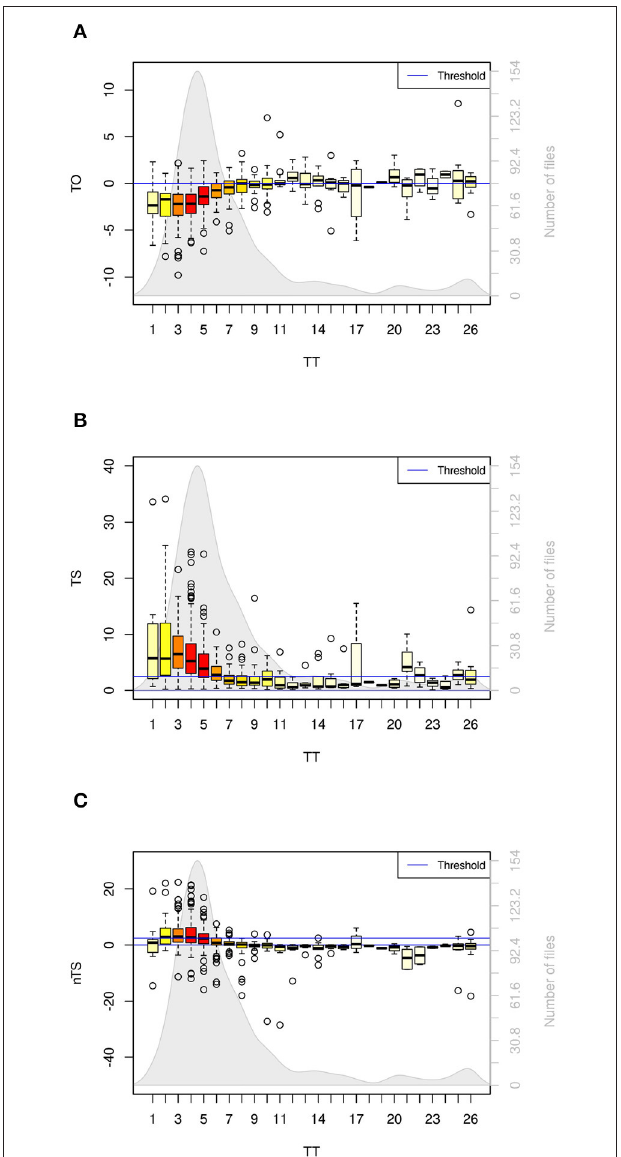
FIGURE 5 | Averaged HRT parameter values of all files grouped by the respective turbulence timing (TT) value. The color of the boxes and the gray background graph illustrate the number of files in the different groups. The common threshold of TO (0%) (A) and TS (2.5 ms/RR) (B) is represented as a blue line. The common cut-off of TS is used for nTS, because no threshold for nTS has been established yet (C) . The median of the groups with low TT (TT ≤ 10 for TO and TT ≤ 6 for TS) lie on the low-risk side of the threshold. For nTS, only the medians of the groups with a TT of 2–4 lie above the